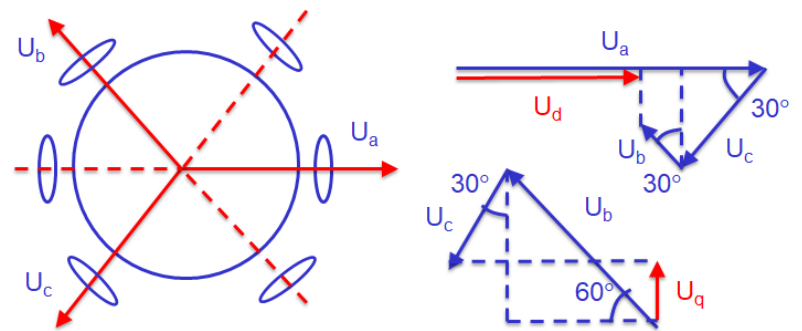
Figure 11. Application of the Clarke transformation to the supply voltage.